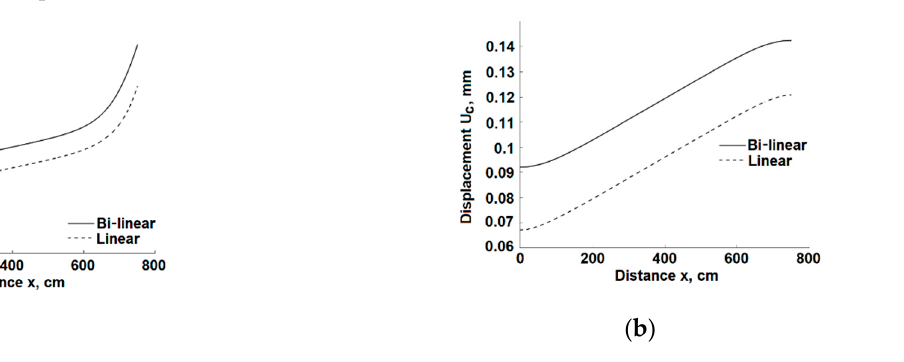
Figure 12. Concrete and rebar displacements along half-length of the element after the 1st cracking stage. ( a ) Rebar; ( b ) Concrete.